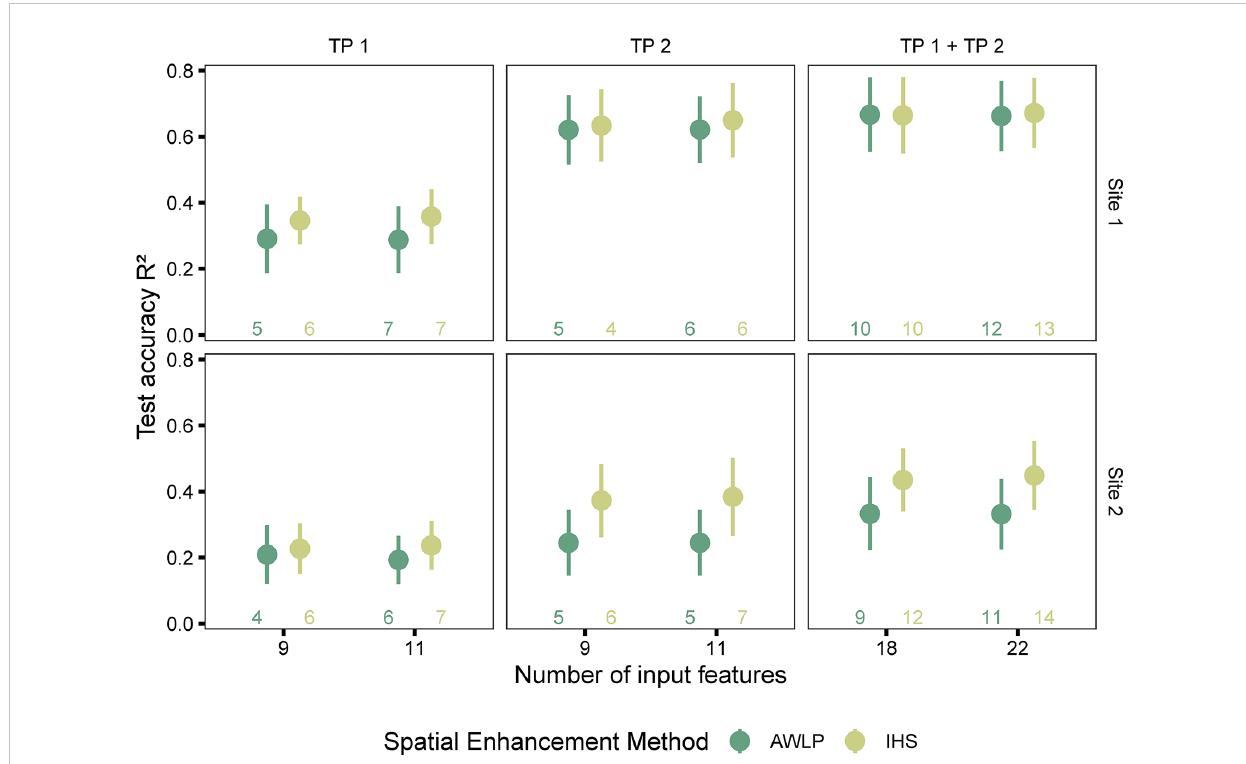
FIGURE 8 Model performance based on spectral data (pan-sharpened imagery developed using integration of satellite and UAS imagery using AWLP and IHS approaches), and time points (individual and combined time points). The number of input features represented as labels of the x-axis indicates the number of features before the correlation fi lter. The colored numbers above the x-axis represent the total number of features retained after the correlation fi lter, which were used to build the random forest